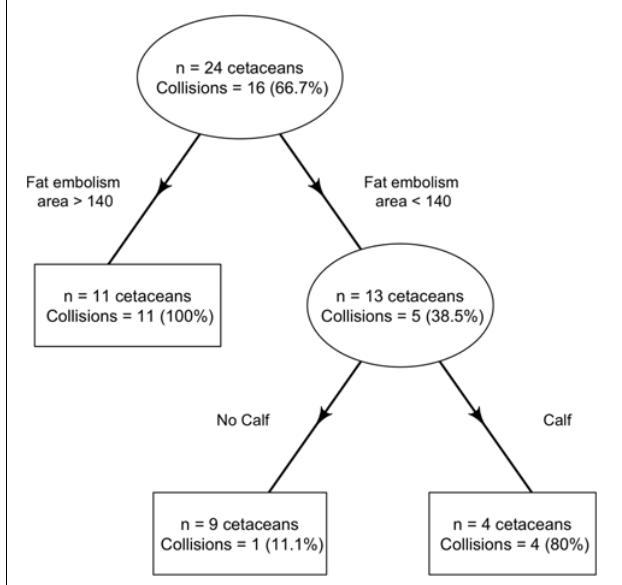
FIGURE 4 | Result of the classification and regression tree to determine the cut off for ship-strike probability of the studied sperm whales. A high or low probability of ship strike was established according to: first, the fat emboli-P75 value and secondly, being a calf or not a calf. If fat emboli area < 140 and Not a Calf → Non-strike group; If fat embolism area < 140 and Calf → Strike group; and if fat embolism area > 140 → Strike group. Its sensitivity is 89% (95% CI = 52–100%) and its specificity 100% (95% CI =